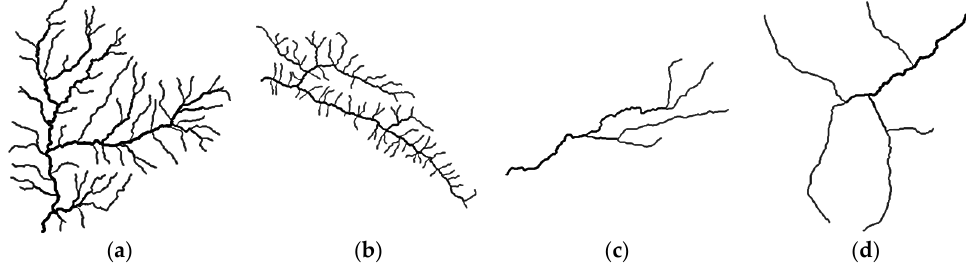
Figure 2. Examples of drainage classification. ( a ) is classified as a dendritic network; ( b ) is recognized as a trellis network; ( c ) is a typical parallel network; ( d ) is an unclassified network.